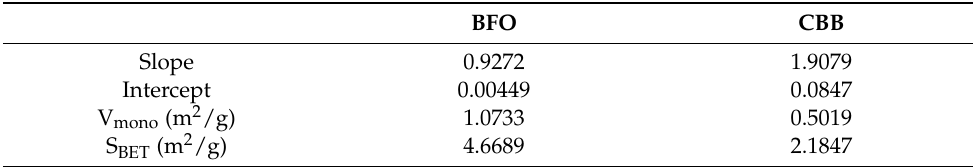
Table 1. BET surface area of BFO and CBB.